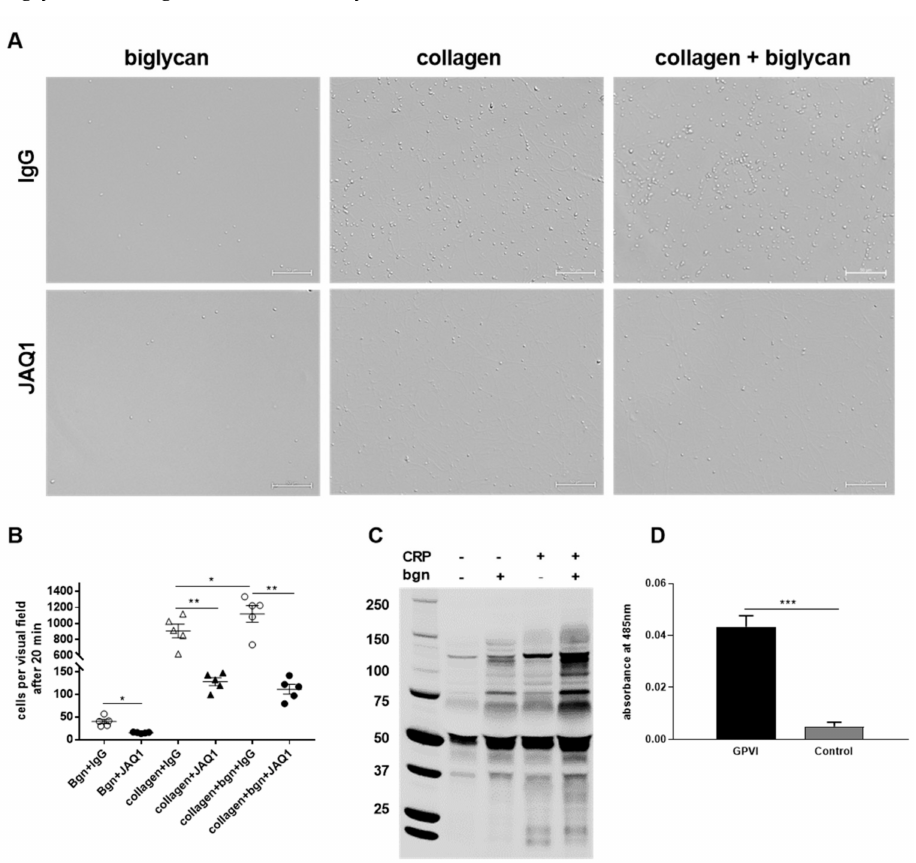
Figure 5. Impact of GPVI on platelet adhesion to biglycan. ( A , B ) Reduced platelet adhesion to immobilized biglycan (10 µ g/mL), collagen (200 µ g/mL), and biglycan-collagen (10/200 µ g/mL) after blocking of GPVI by antibody treatment (JAQ1, Emfret analytics, 2 µ g/mL). Control platelets were treated with an IgG antibody. ( A ) Representative images and ( B ) quantitative analysis of adherent platelets. Scale bar = 50 µ m, n = 5, mean values ± SEM. Statistical analysis was performed with one-way ANOVA followed by Sidak’s post hoc test. ( C ) Western blots show protein tyrosine phosphorylation of platelets stimulated with collagen-related peptide (CRP) and recombinant bigly- can. Enhanced phosphorylation was detected in platelets stimulated with CRP (5 µ g/mL) and biglycan (10 µ g/mL) compared to with CRP or biglycan alone, n = 5. ( D ) Pentameric GPVI binds to BGN (100 ng/uL immobilized on MaxiSorp plate), while a negative control protein (ACVR1) does not, n = 3–5, two-tailed, unpaired Student’s t -test with Welch’s correction. * p < 0.05, ** p < 0.01, *** p <